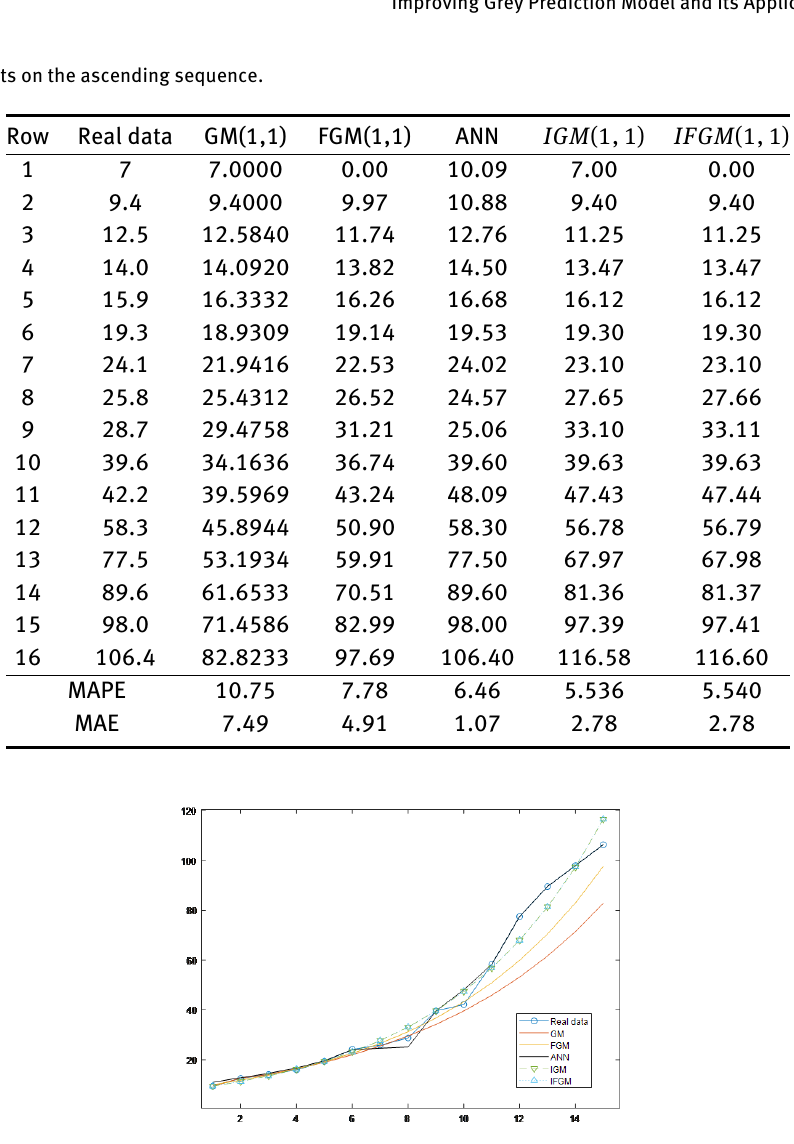
Figure 3: Matching of the modeled values with the corresponding real data in the ascending sequence.